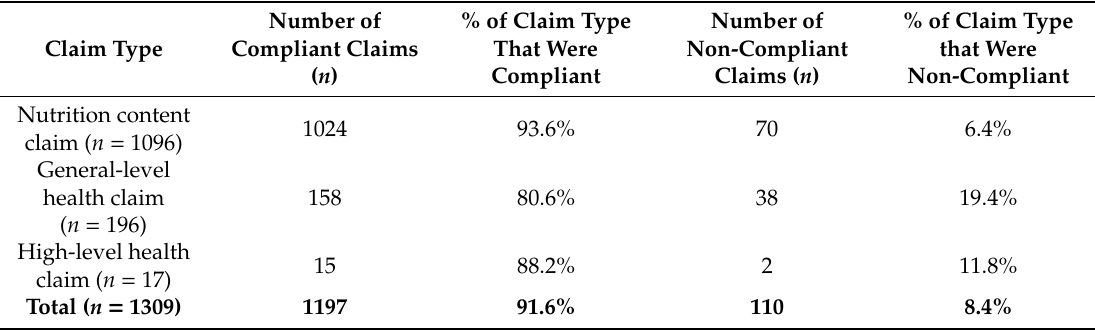
Table 4. Number and proportion of claims compliant with regulations; Food Standards Australia